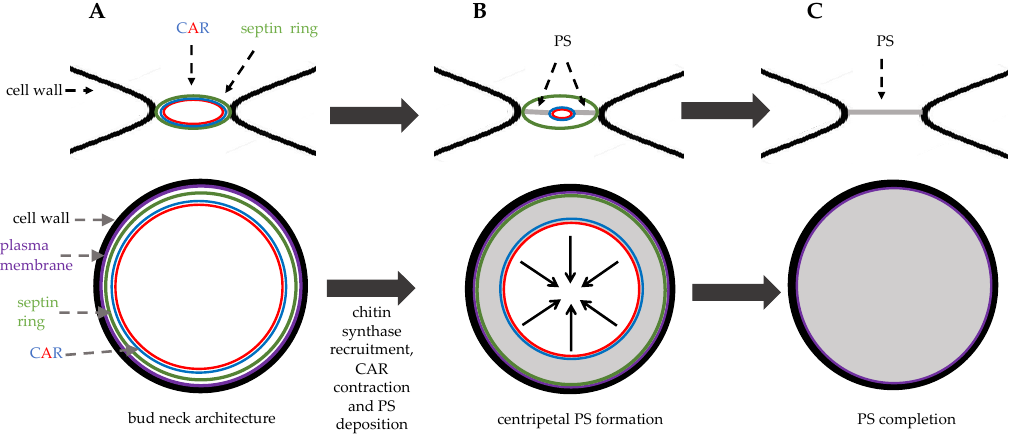
Figure 3. Bud neck structure during cytokinesis. Top panels: side view, bottom panels: top view. ( A ) in late anaphase septin ring and the contractile ring (CAR) are assembled at the bud neck. ( B ) in late anaphase the chitin synthase Chs2 is recruited to the bud neck and the primary septum (PS, grey area) is synthetized centripetally. ( C ) just before cell separation PS deposition is completed leading to physical dissociation of mother and daughter cytoplasms.